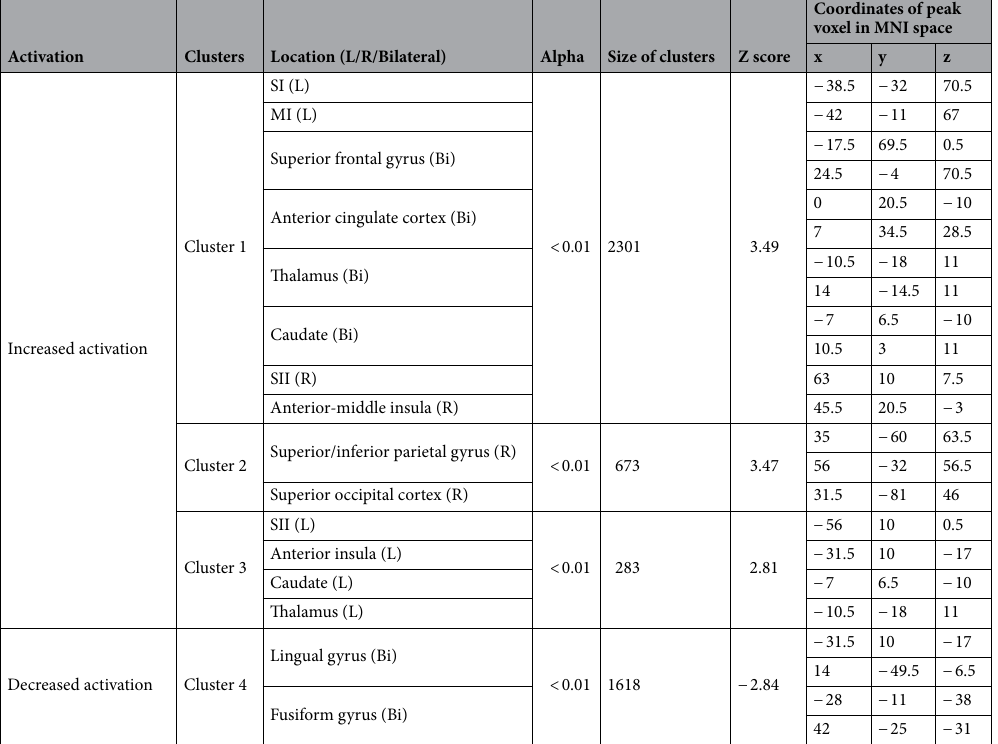
Table 1. Brain regions showing increased or decreased activation in response to painful mechanical stimulation. Clusters of brain regions where activity was significantly increased or decreased during mechanical pain stimulation in all trials regardless of learning type and visual cue during the test session. The results were corrected for multiple comparison at a cluster-level threshold of p < 0.05, and the cluster size was determined by permutations (n = 1000). Bi, bilateral; L, left; MI, primary motor cortex; MNI, Montreal Neurological Institute; R, right; SI, primary somatosensory cortex; SII, secondary somatosensory